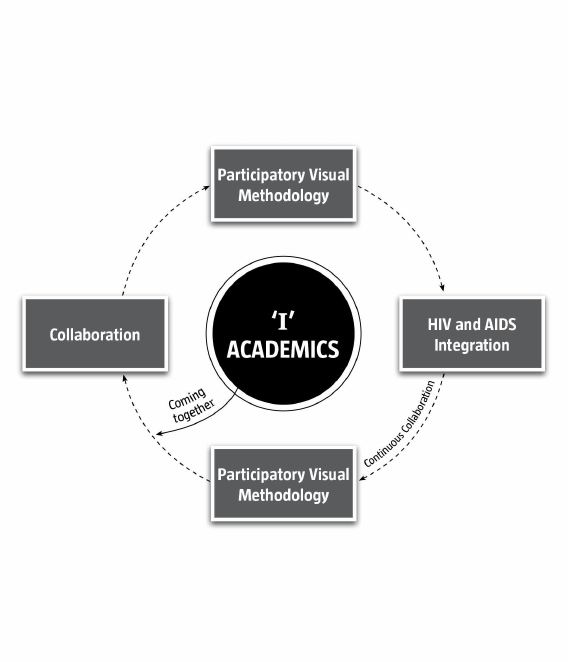
Figure 1: The cyclical process of working collaboratively using PVM during the HIV and AIDS curriculum integration